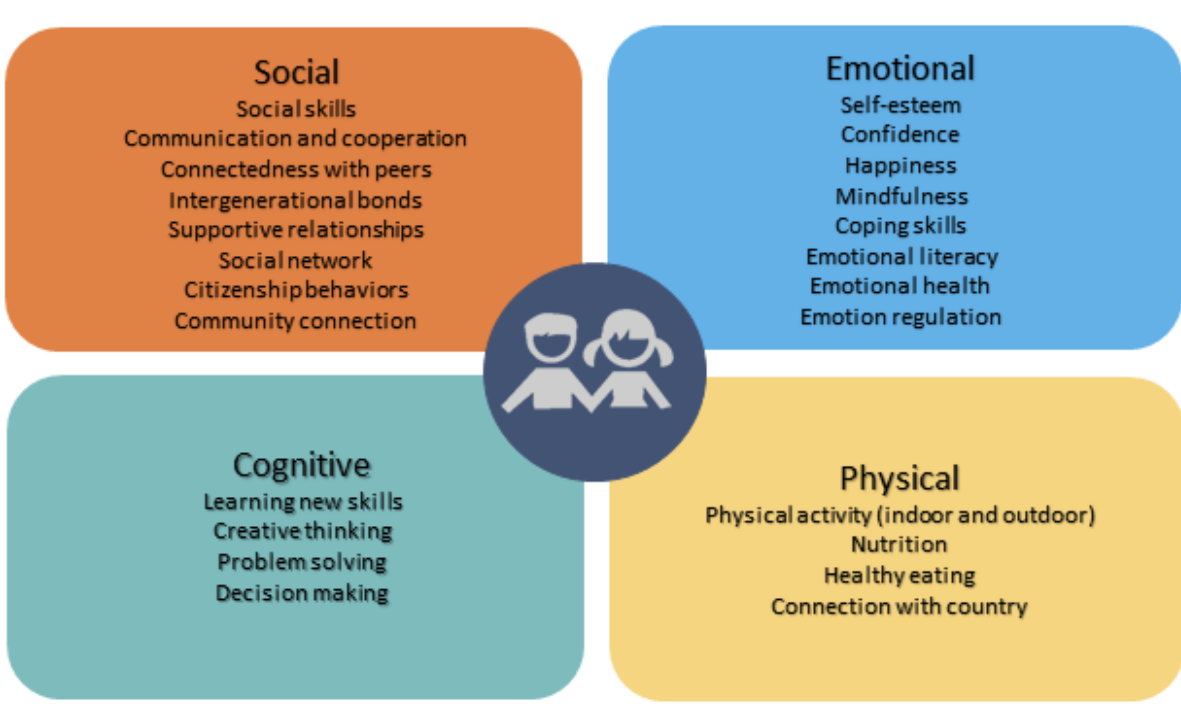
Figure 2. Children’s wellbeing